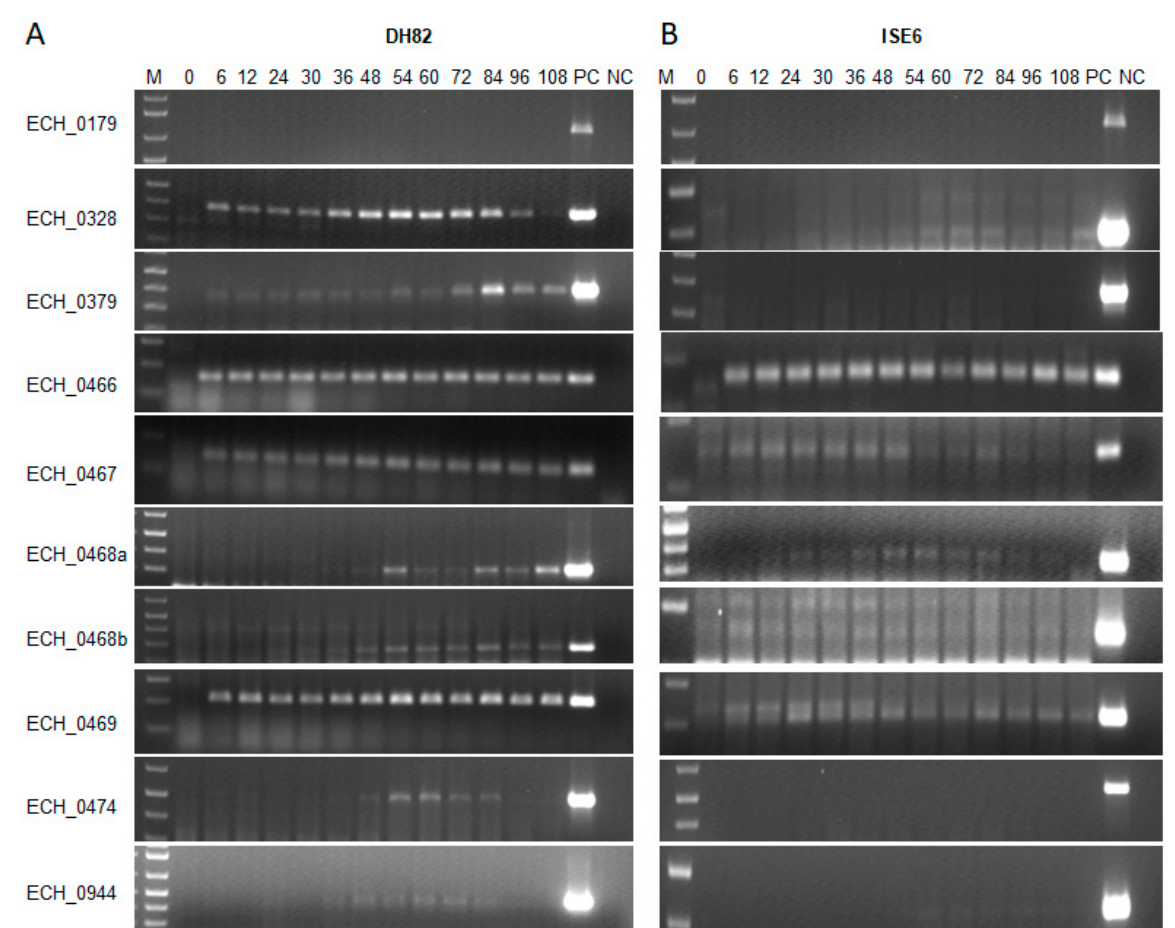
Figure 2. ( A ) Transcription assessed for the E. chaffeensis antiporter genes during the replication in macrophage (DH82) and ( B ) tick cell (ISE6) cultures. RNA concentration was measured by qRT-PCR targeted to the 16S rRNA and input RNA for each sample was normalized based on the 16S rRNA concentrations. The transcript levels for the targeted genes were then determined by semi-quantitative PCR with varying numbers of amplification cycles per target, which ranged from 25 to 40 cycles. The transcript levels were measured for different post-infection times: 0, 6, 12, 24, 30, 36, 48, 54, 60, 72, 84, 96, and 108 h. Positive controls (PC) for the assays included E. chaffeensis genomic DNA as the template. Negative controls (NC) had nuclease-free water as the template. The lowest number of temperature cycles where we noted the expression for each gene are presented: ECH_0179 (45 cycles), ECH_0328 (35 cycles for DH82 and 45 cycles for ISE6), ECH_0379 (35 cycles for DH82 and 45 cycles for ISE6), CH_0466 (35 cycles for DH82 and 40 cycles for ISE6), ECH_0467 (35 cycles for DH82 and 45 cycles for ISE6), ECH_0468a (5 ′ ) (45 cycles for DH82 and 35 cycles for ISE6), ECH_0468b (3 ′ ) (35 cycles for DH82 and 45 cycles for ISE6), ECH_0469 (30 cycles for DH82 and 45 cycles for ISE6), ECH_0474 (35 cycles for DH82 and 45 cycles for ISE6), and ECH_0944 (45 cycles).